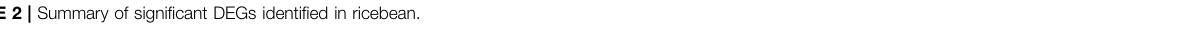
TABLE 2 | Summary of signi fi cant DEGs identi fi ed in